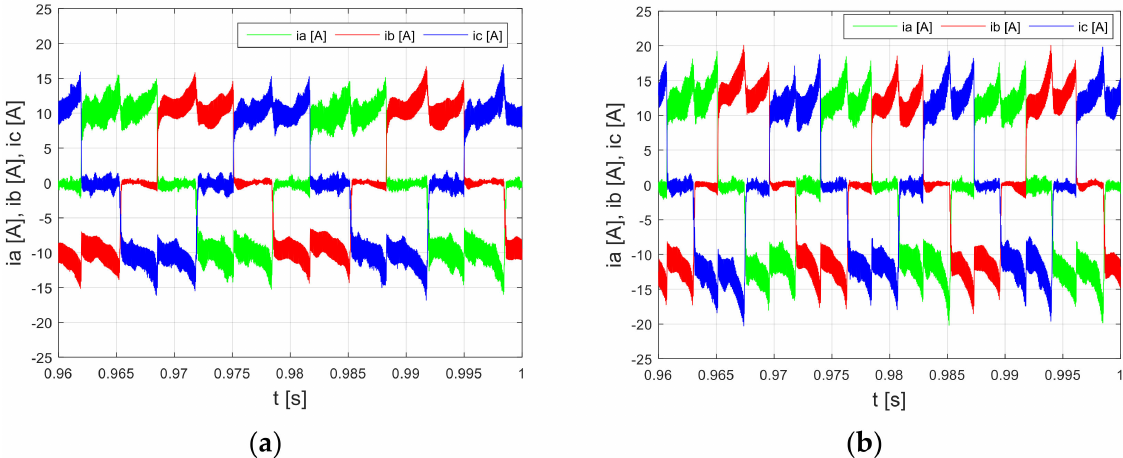
Figure 12. Phase-current waveforms (ia, ib, ic) at the 60 bar pressure for the speed of: ( a ) 1000 rpm; ( b ) 1500